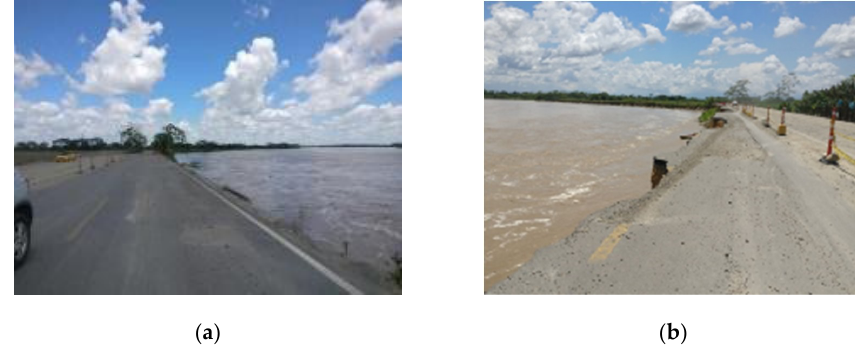
Figure 24. Ariari River, PR68: ( a ) road sector threatened by the river, without damage (before 2016);